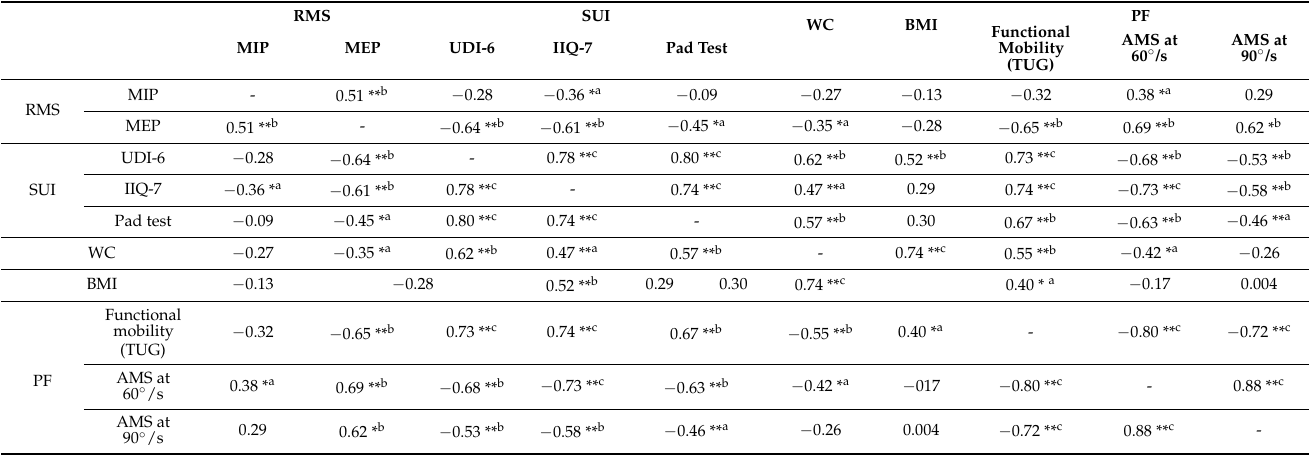
Table 2. Spearman correlation coefficient “r” analysis for relationships between respiratory muscle strength (RMS), stress urinary incontinence (SUI), waist circumference (WC), body mass index (BMI), and physical function (PF) in incontinent women ( n =